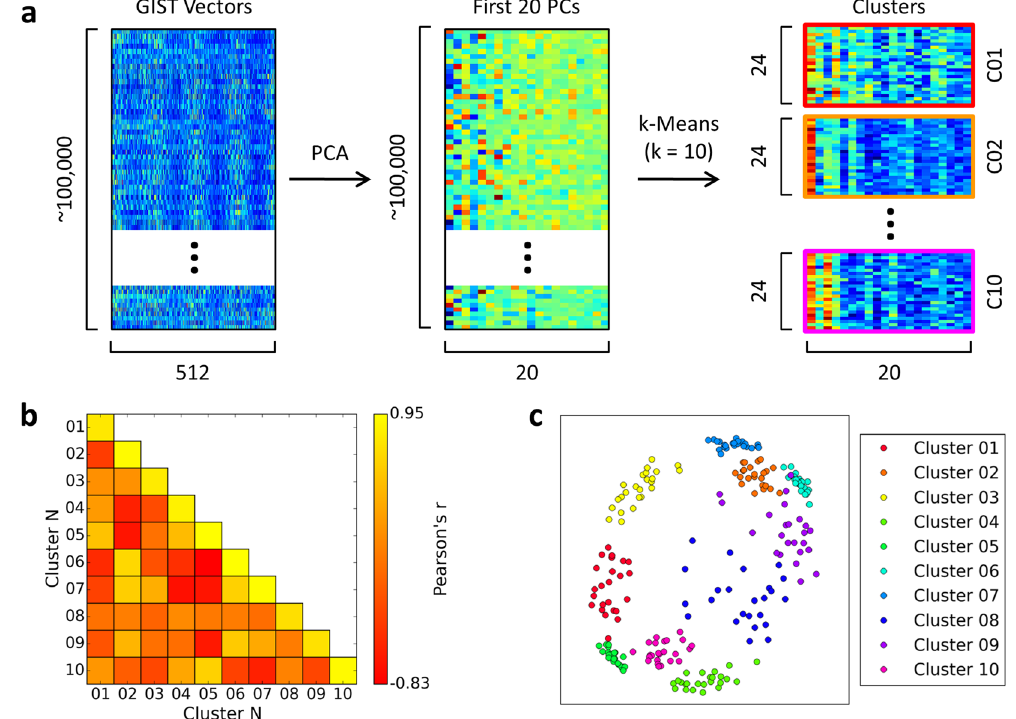
Figure 1. GIST clustering process. The GIST descriptor 18 comprises a vector of 512 values that represent the image in terms of the spatial frequencies and orientations present within each of 16 spatial locations across the image. ( a ) GIST descriptor vectors were calculated for every image in the SUN database. PCA was used to reduce dimensionality down to the first 20 components, and a k-Means clustering algorithm then used to select 10 clusters of scenes. Finally, the 24 images nearest the centroid of each cluster were selected to form the final stimulus set. The structure of the feature space is illustrated by the correlations similarity matrix ( b ) and multi- dimensional scaling plots ( c ). Examples of the images from each scene cluster are available at https://figshare.